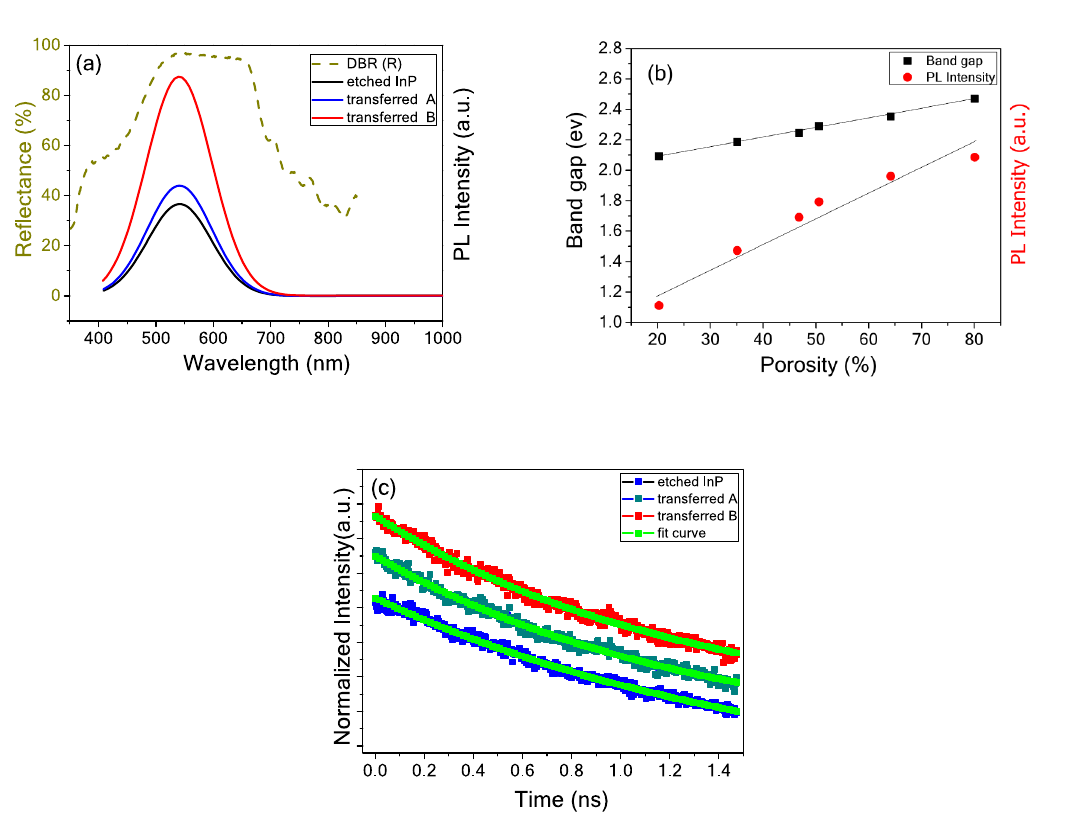
Figure 5. ( a ) PL spectra (solid line) of three nanoporous InP samples and reflectance spectra of DBR (dotted line), ( b ) band gap energy and PL Intensity vs. porosity with different etching voltage, and ( c ) normalized luminescence decay of three nanoporous InP